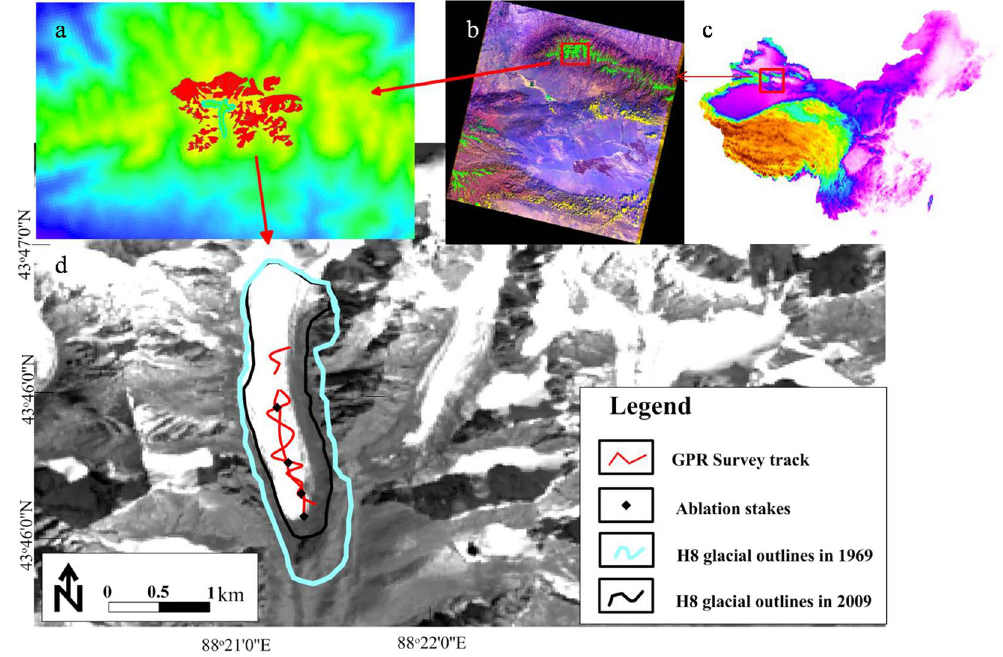
Figure 1. Overview of the study sites and GPR track. ( a ) The overall outline of the H8 and the map was plotted using ArcGIS 10.2 (http://www.esri.com/). ( b ) The Landsat image of glacial location (https://glovis.usgs.gov/). ( c ) Digital Elevation Model (DEM) in Mainland China. ( d ) The glacial outlines in 1969 and 2009 extracted separately from Chinese Military Geodetic Service maps and Landsat image (https://glovis.usgs.gov/). The map was plotted using ArcGIS 10.2 (http://www.esri.com/) and Surfer 16